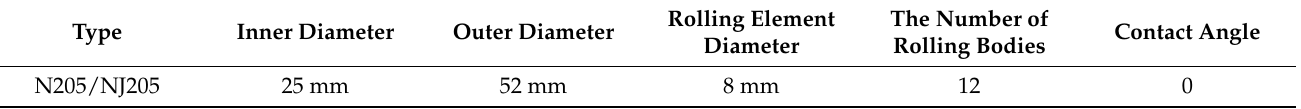
Figure 11. Test bench for rolling bearing fault diagnosis.